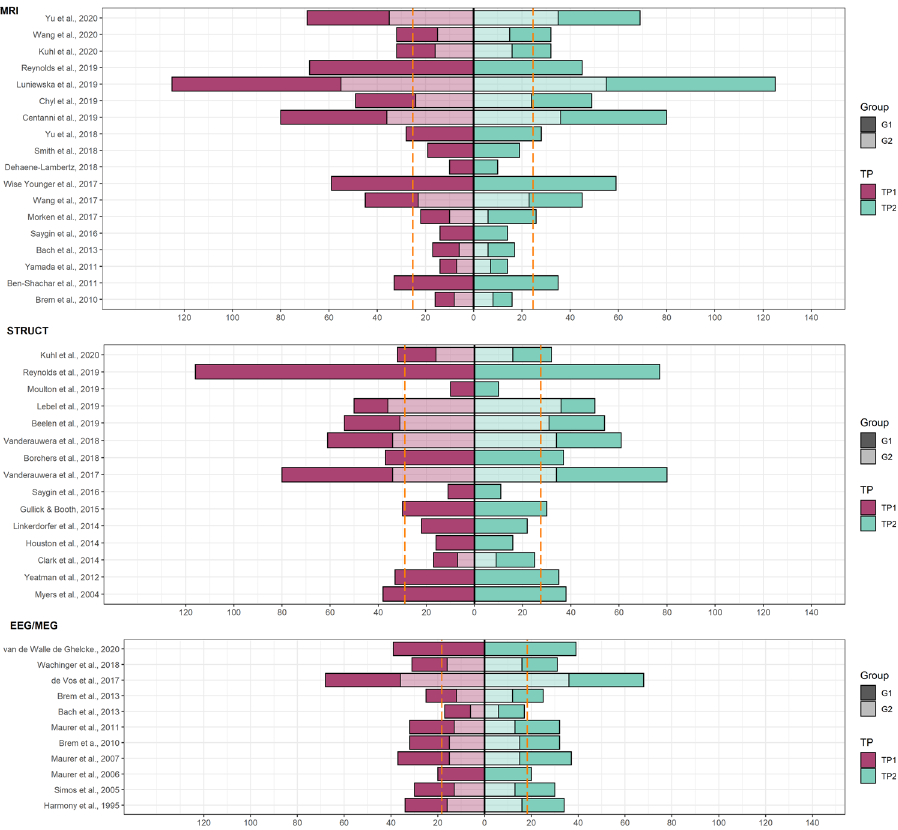
Fig. 2 Illustration of sample sizes of studies with longitudinal EEG, fMRI and structural (WM, GMV) neuroimaging data. NOTE: Dashed orange lines indicate mean sample size across groups for a measurement time point. The darker portion of the bar indicates the control group and the lighter portion indicates the subsample of dyslexic, poor readers or at risk group depending on the study. Left-oriented bars correspond to the fi rst time point and right-oriented bars to the second time point. For clarity purposes, only samples for two time points and sample sizes in the comparisons with the largest groups are